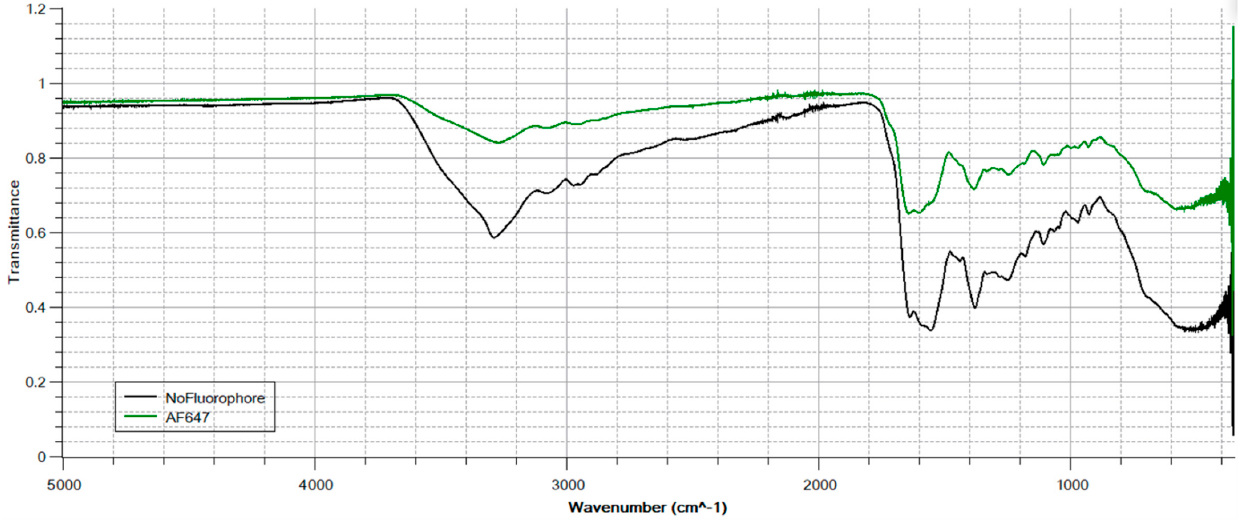
Figure 5. Fourier-Transform Infra-Red Spectroscopy graph of AuNP samples with and without the cross-linked fluorophore.